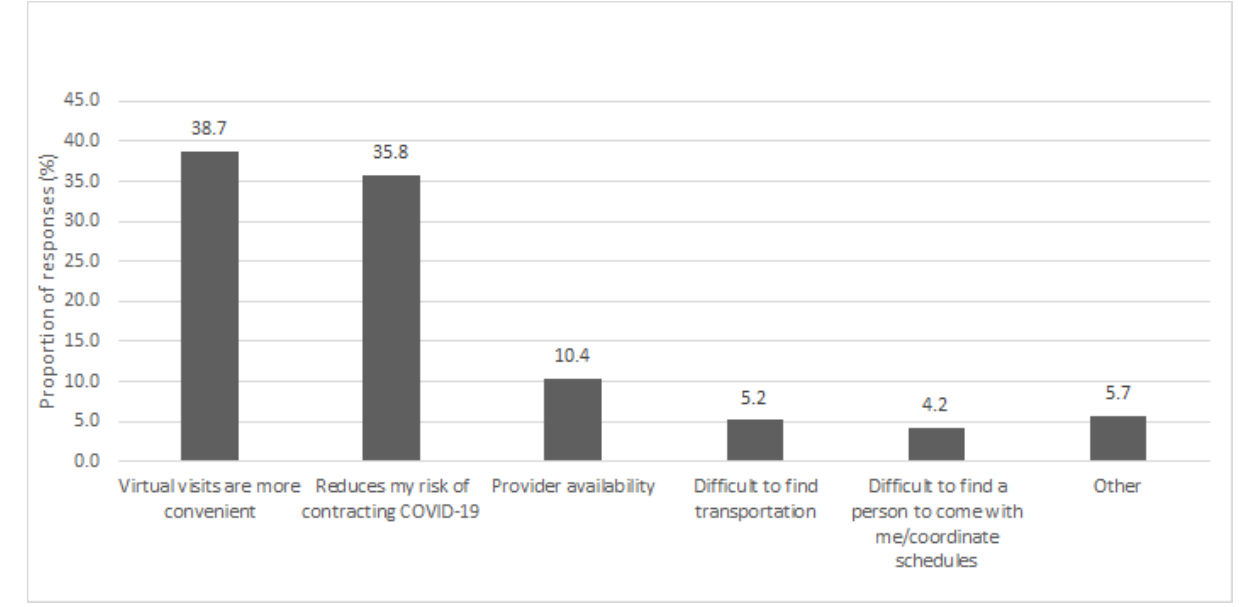
Figure 3. Factors influencing anticipated participation in virtual care after clinics open for in-person visits.